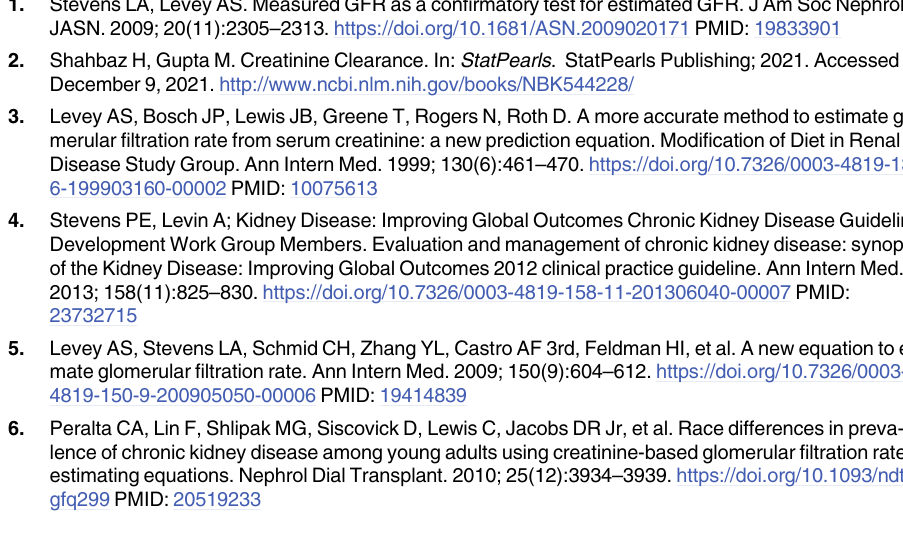
S4 Table. Correlation or concordance tables for CKD-EPI without race adjustment. S5 Table. QUADAS-2 risk of bias and applicability assessment of studies not included in the systematic review